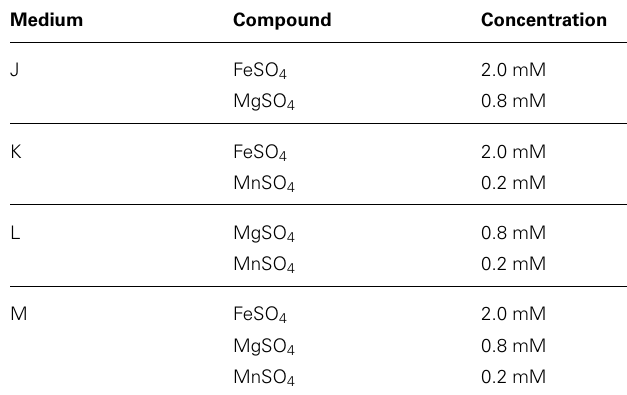
Table 4 | Combinations of metal salts assayed for studying its effect on the biosurfactant production by B. subtilis #573. Medium